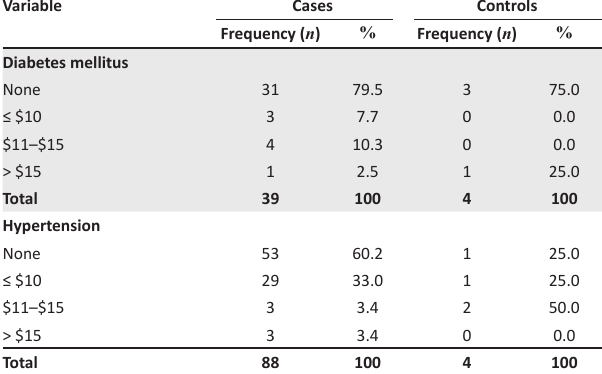
TABLE 4: Average monthly amount of money spent on medication